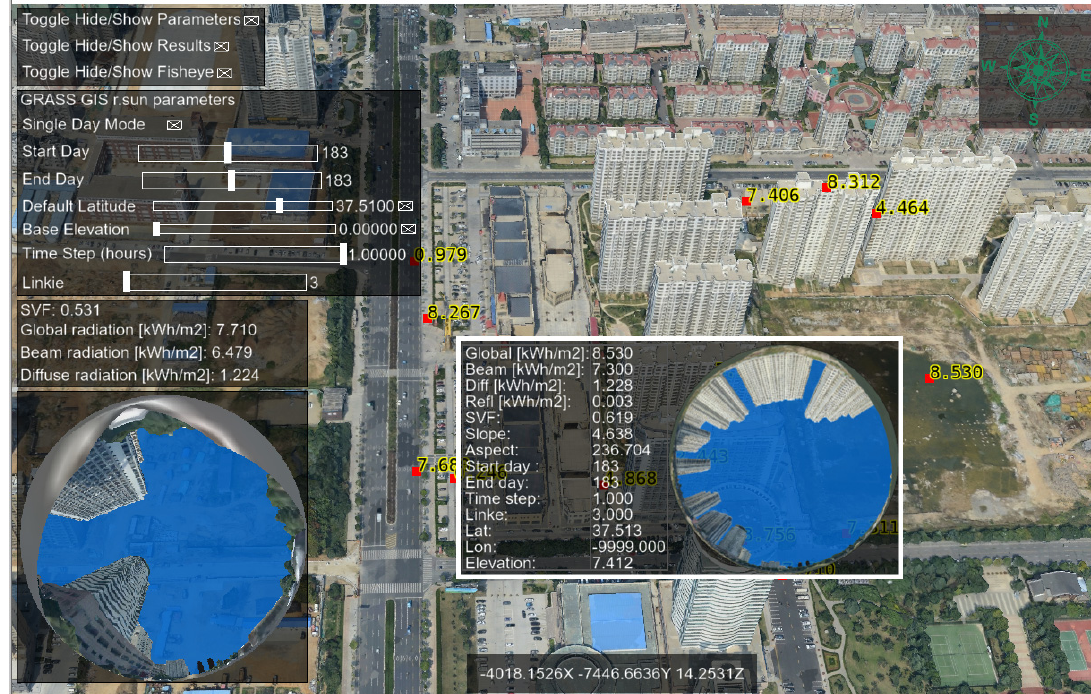
Figure 5. Calculating solar irradiation with an OAP3D in Solar3D. ISPRS Int. J. Geo-Inf. 2020 , 9 , x FOR PEER REVIEW